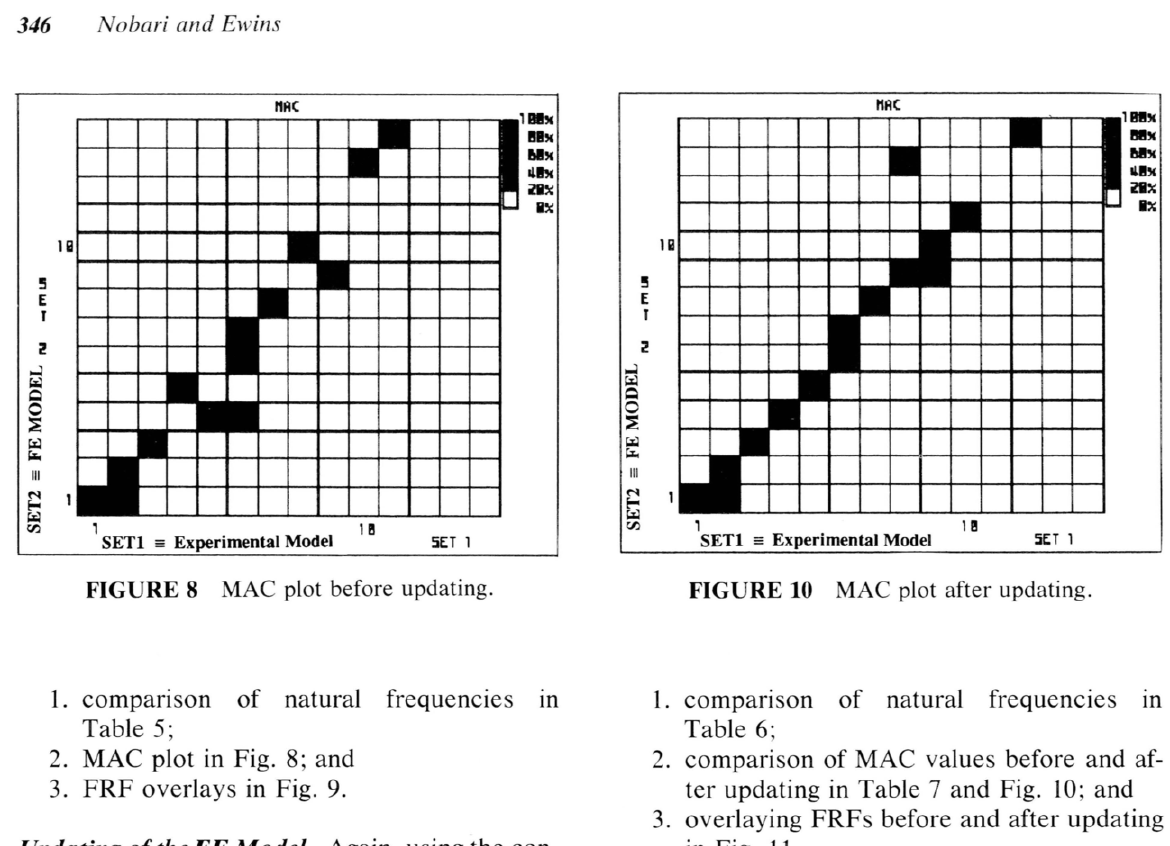
2. comparison of MAC values before and af ter updating in Table 7 and Fig. 10; and 3. overlaying FRFs before and after updating in Fig. 11.